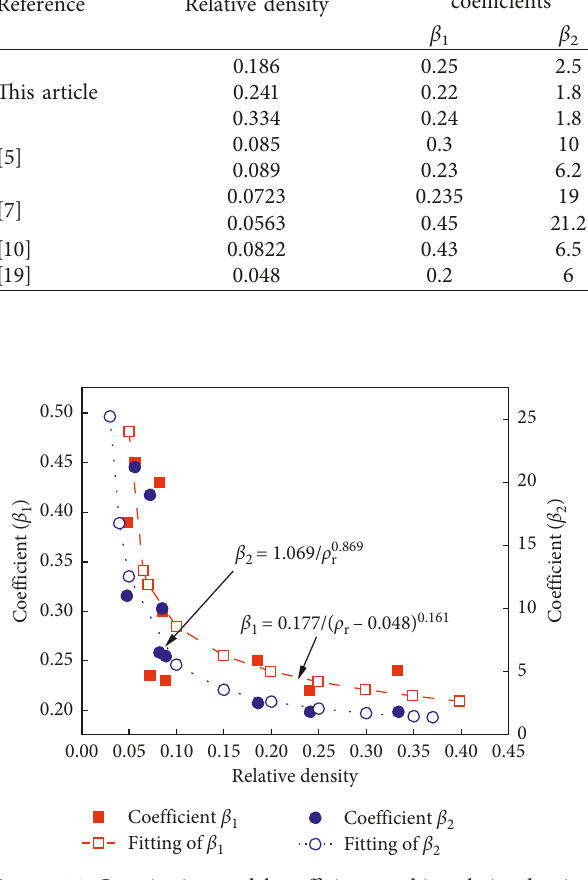
Figure 11: Constitutive model coefficients and its relative density.